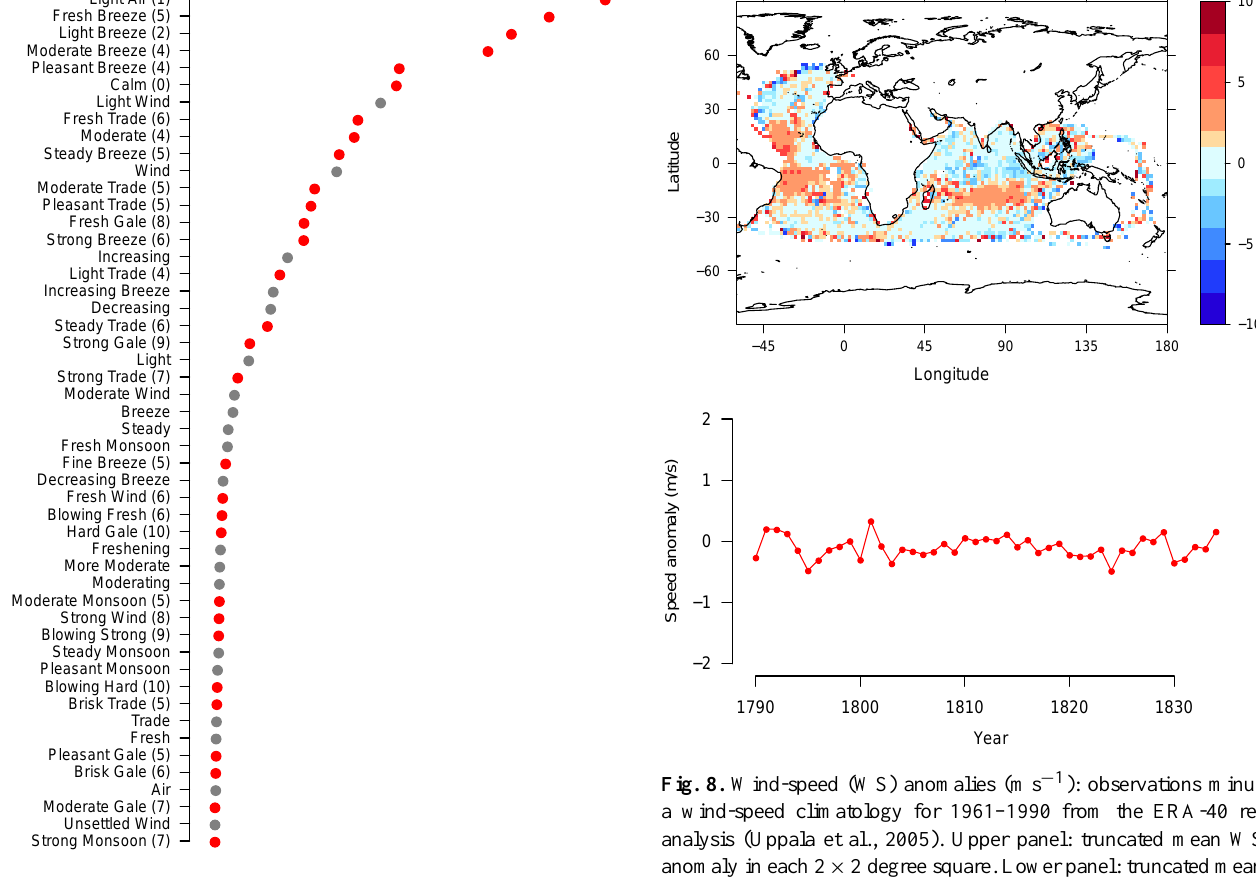
Fig. 7. The most common wind-force descriptors in the logs. Red points mark descriptors that can be converted to a Beaufort force using the CLIWOC dictionary (the Beaufort category is given in brackets after the descriptor in these cases). Grey points are terms which can’t be converted.